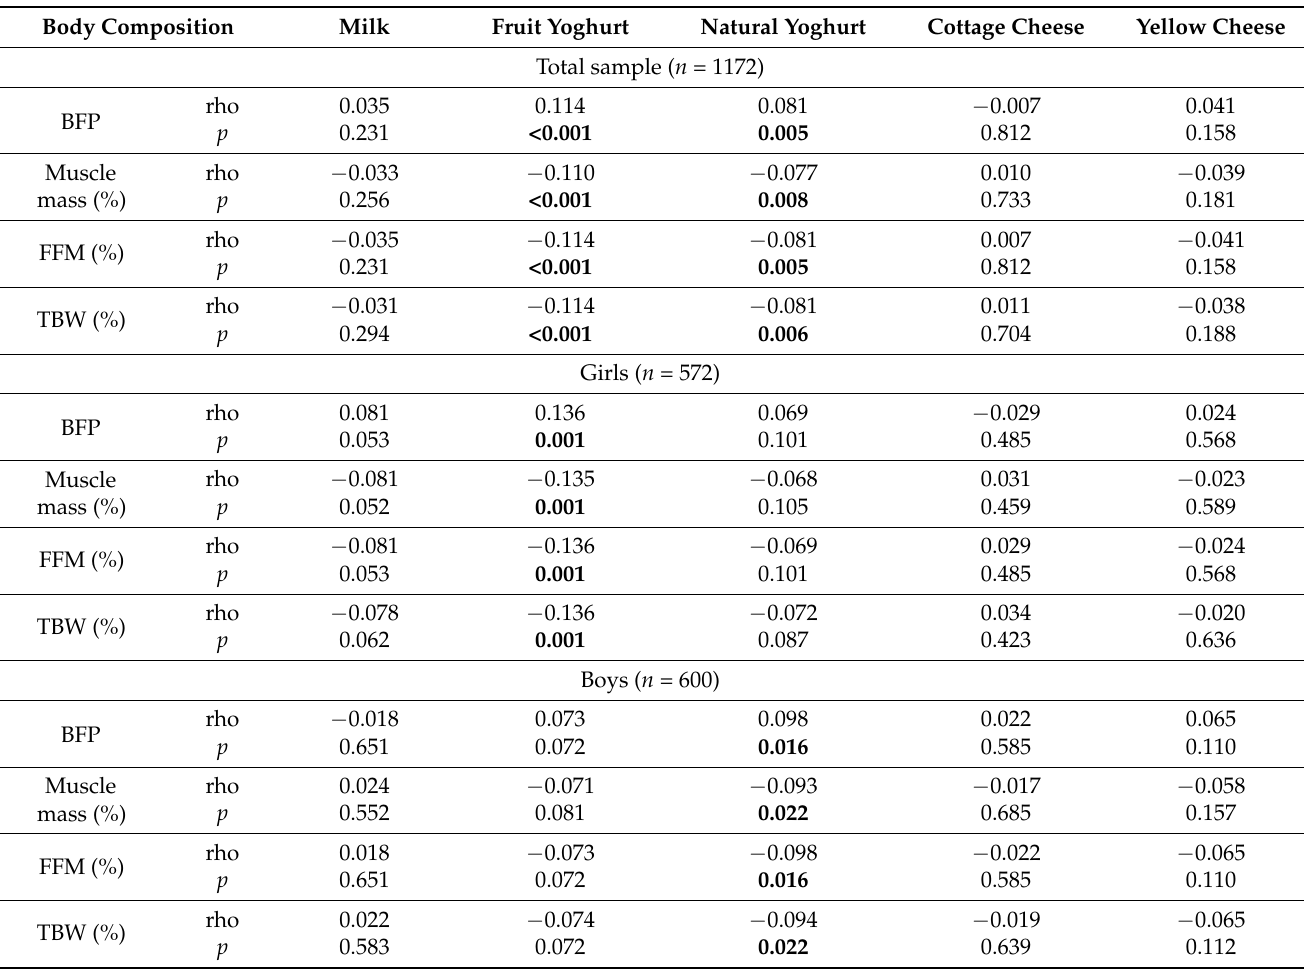
Table 3. Associations between dairy consumption and body composition among the study